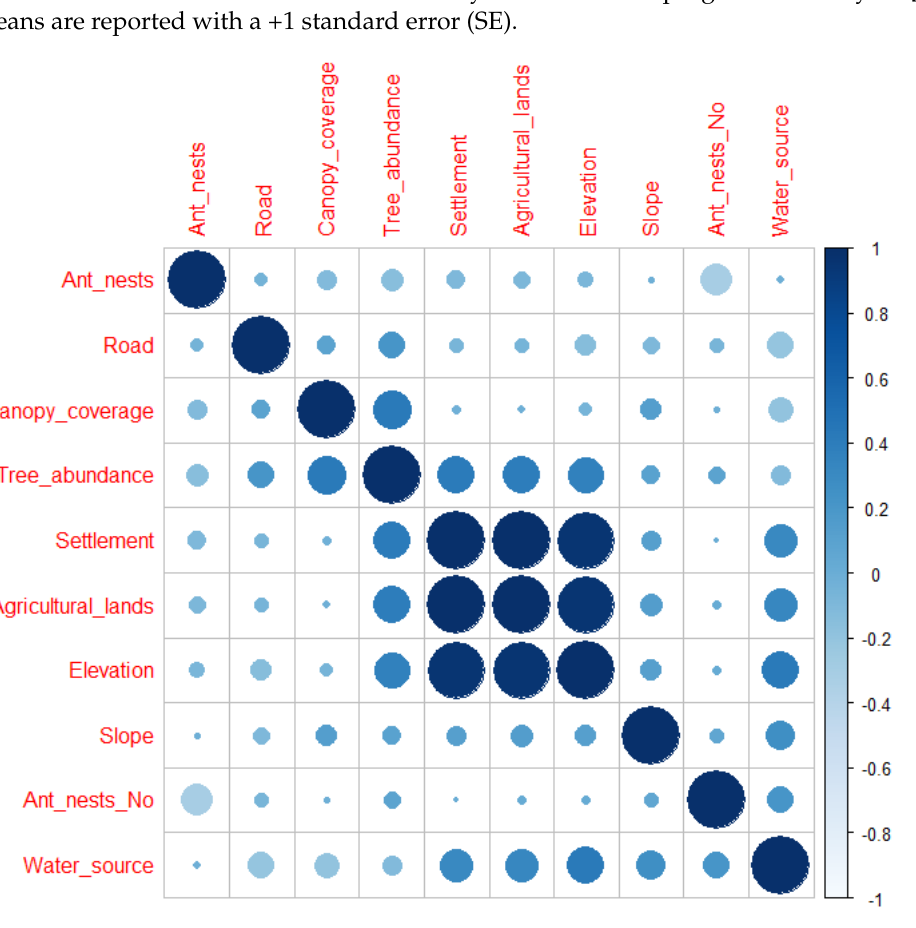
Figure 2. Correlation matrix between predictive variables to estimate factors influencing Chinese pangolin foraging burrow occurrence in Chandragiri Municipality, Nepal. Variables Ant_nests = distance to nearest ant nest, Road = distance to nearest road, canopy_coverage = % forest canopy coverage, Tree_abundance = number of trees, Settlement = distance to nearest settlement, Agricultural_land = Distance to nearest agricultural land, Ant_nest_no = number of ant nests and water_source = distance to nearest water source.